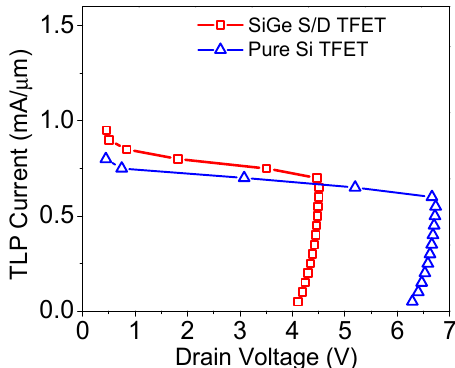
Figure 4. Transmission line pulsing (TLP) I-V curves of the SiGe S/D TFET and Si TFET.